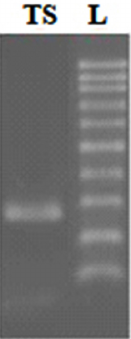
Fig. 1. Visualization of PCR amplified 16srDNA fragment (~1.4kb) on 1% agarose gel. TS: amplified bacterial genomic DNA; L: 500bp DNA